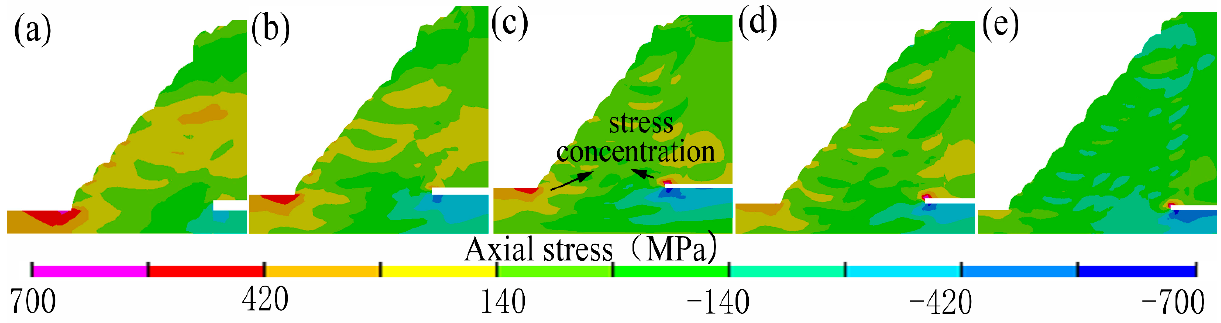
Figure 16. Axial residual stress distribution: ( a ) case A, ( b ) case B, ( c ) case C, ( d ) case D, ( e ) case E.